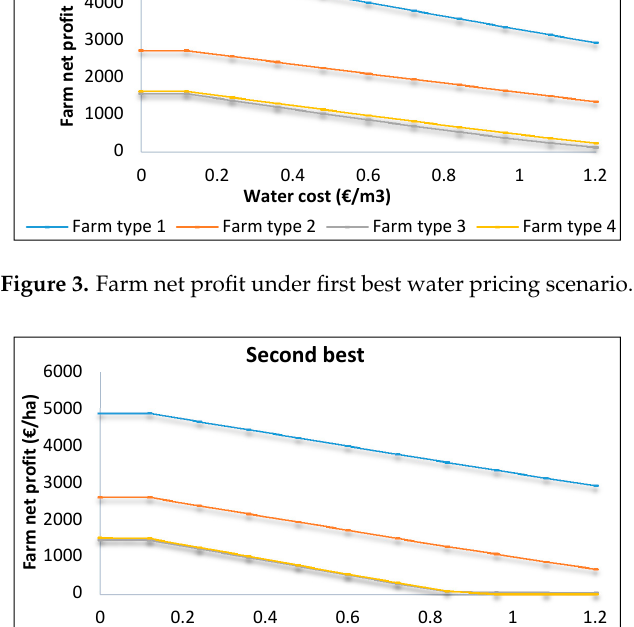
Figure 4. Farm net profit under second best water pricing scenario.